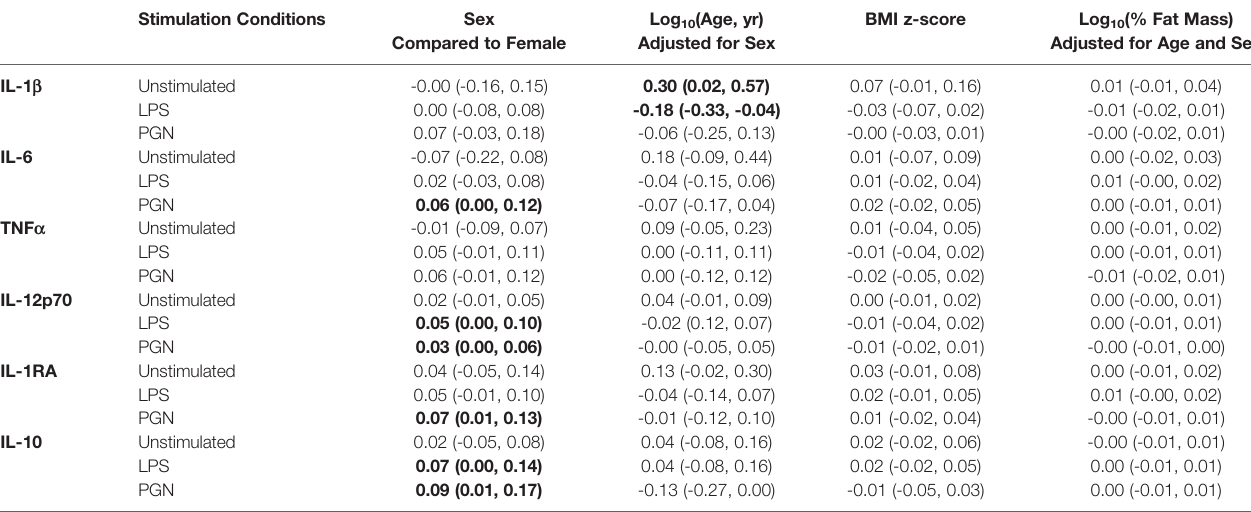
TABLE 2 | Association between sex, child age, and adiposity, and log transformed cytokine levels under unstimulated and stimulated conditions. Stimulation